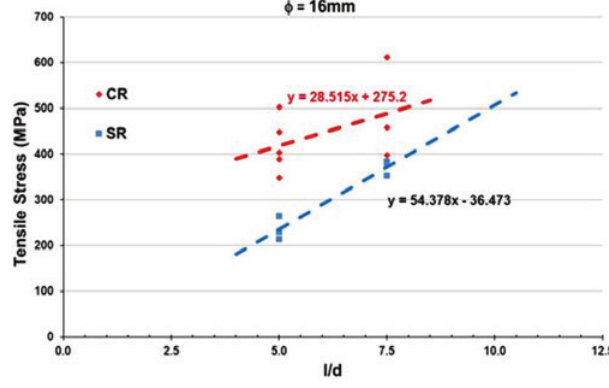
Figure 22 Bar Tensile Stress - l /d relationships, d=12.5mm